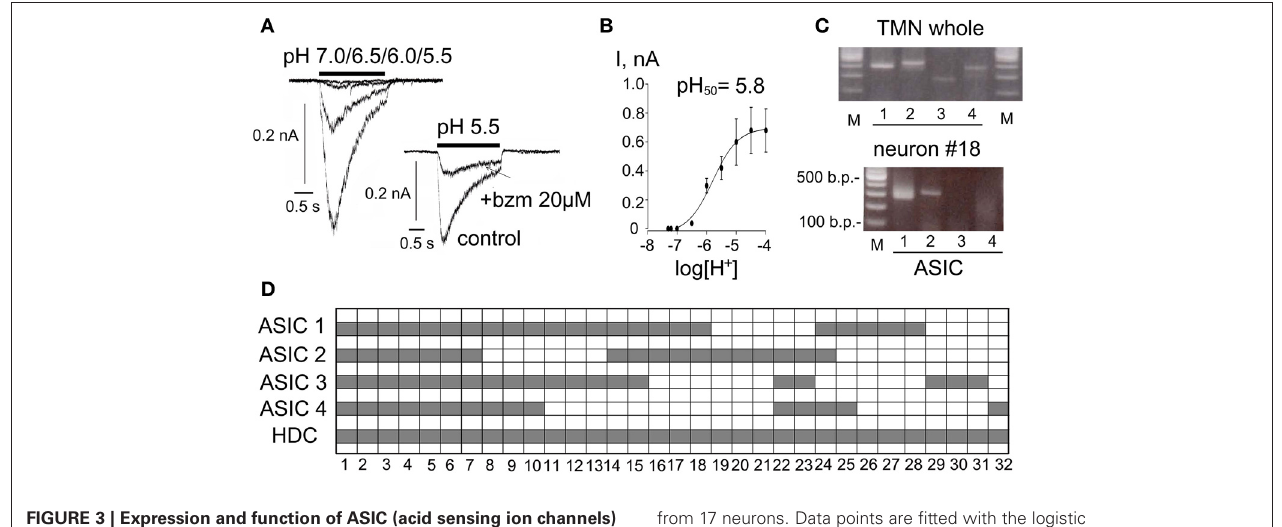
FIGURE 3 | Expression and function of ASIC (acid sensing ion channels) in TMN neurons. (A) Acid-induced currents in two representative neurons. Neurons are moved to the test solution with indicated pH for 2s from the control ACSF (pH 7.4). Benzamil hydrochloride (bzm) abolishes the fast inactivating phase of the response and reduces the non-desensitizing component. (B) Averaged current-pH histogram represents data obtained